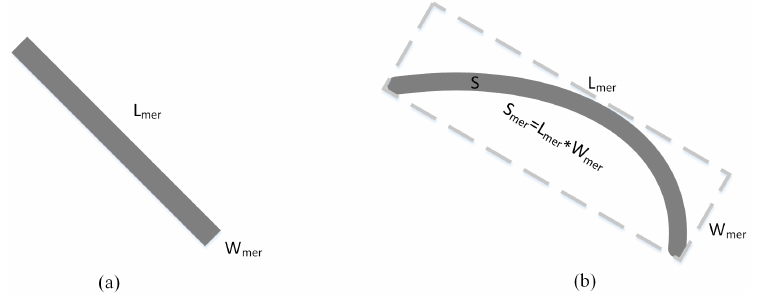
Figure 10. ( a ) Straight-road-object model; ( b ) curved-road-object model.